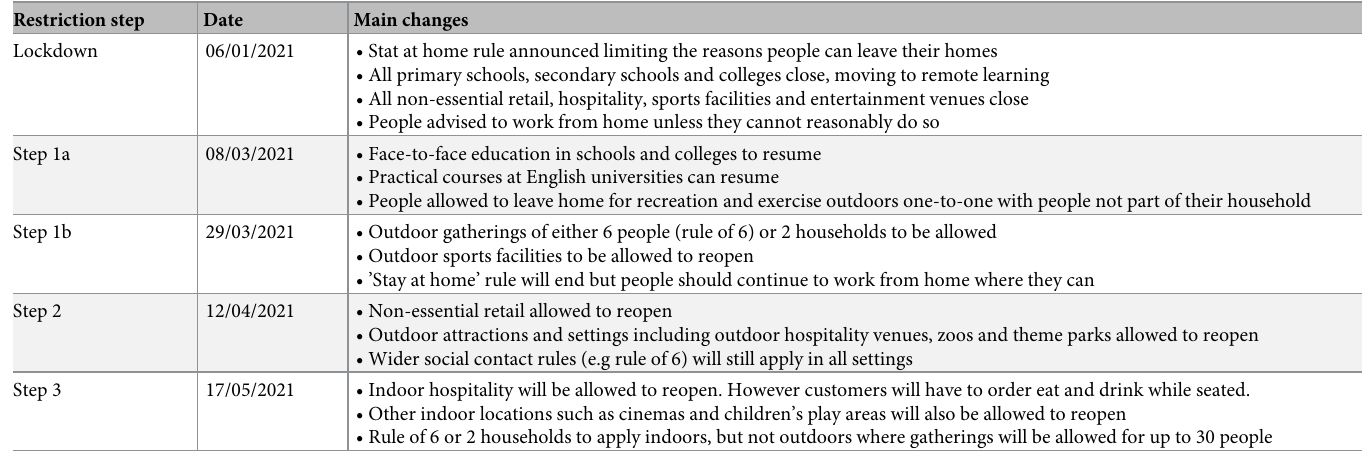
Table 1. Summary table of changes in restrictions over the period of rounds 8–13 of the REACT-1 study